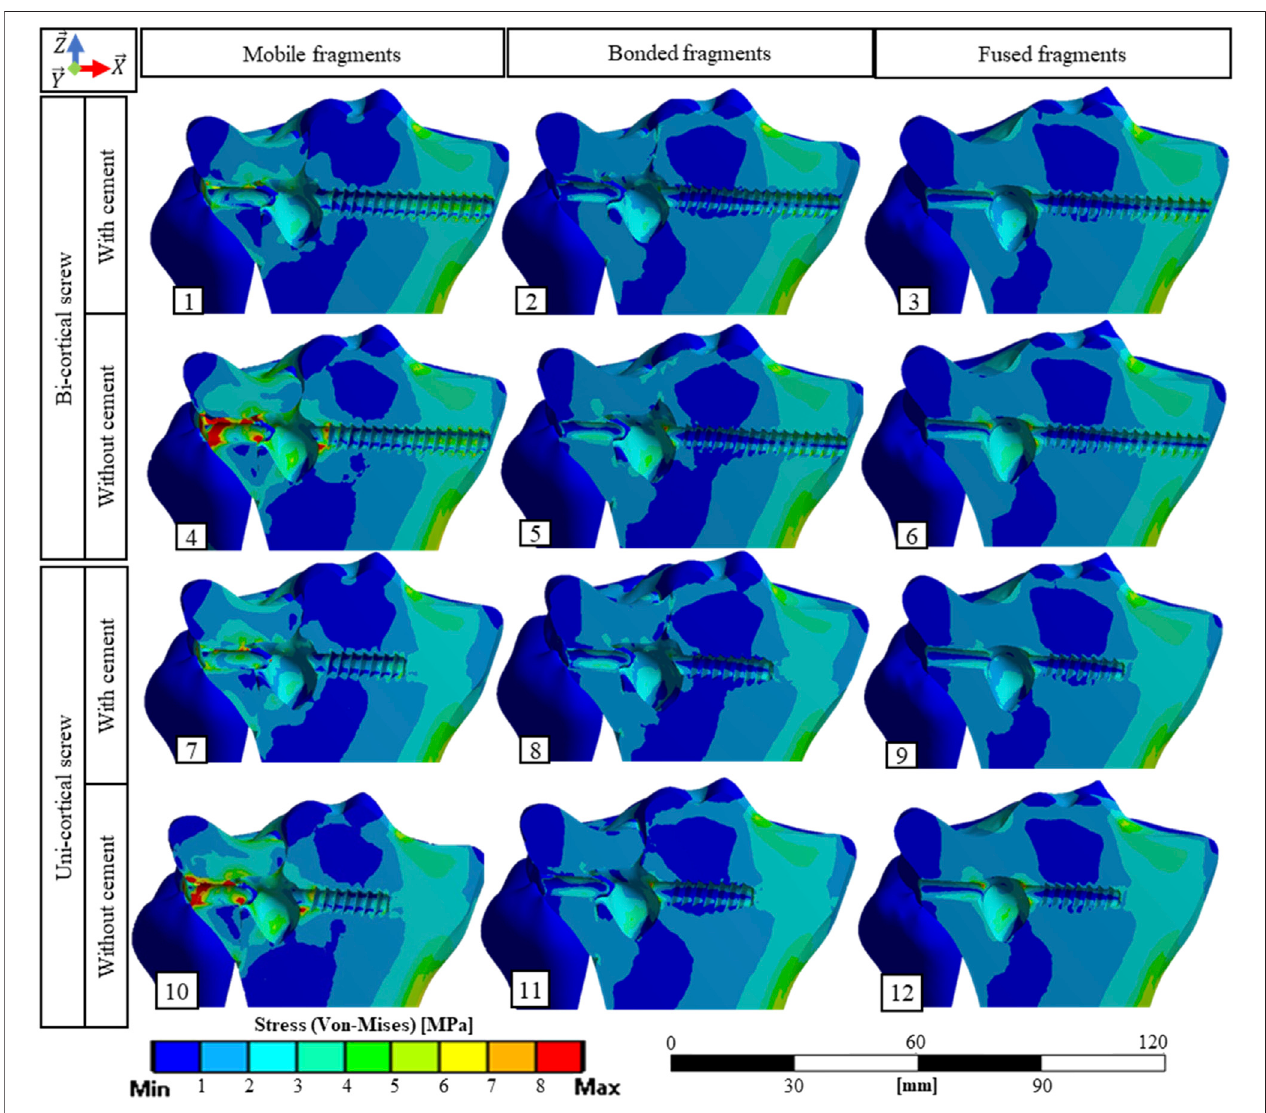
FIGURE3| Stress fi elds(vonMises)inbonematerialonacrosssectioncontainingthescrewaxisforthe12simulatedscenarios.Themaximumstressvaluesinthe bone for each scenario are presented Figure 5A .